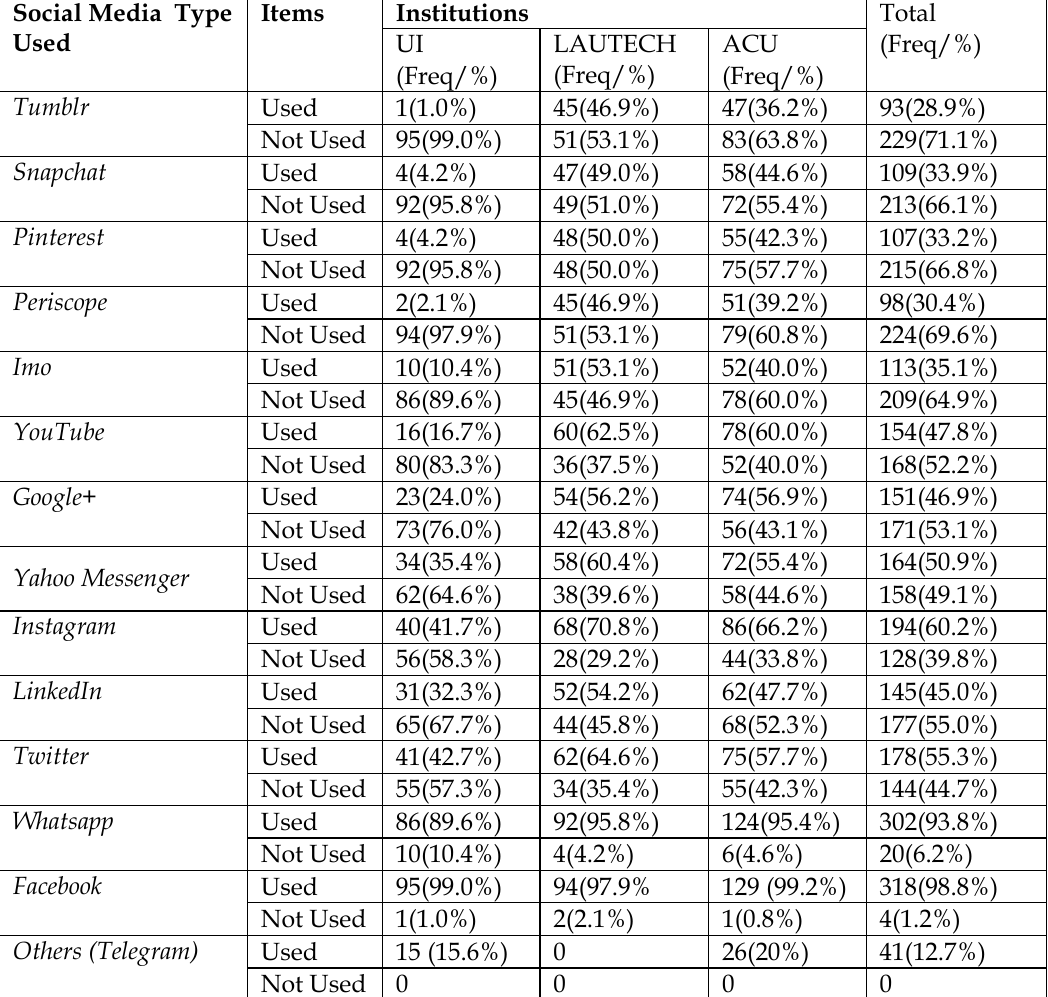
Table 5: Distribution of social media type used for political participation Social Media